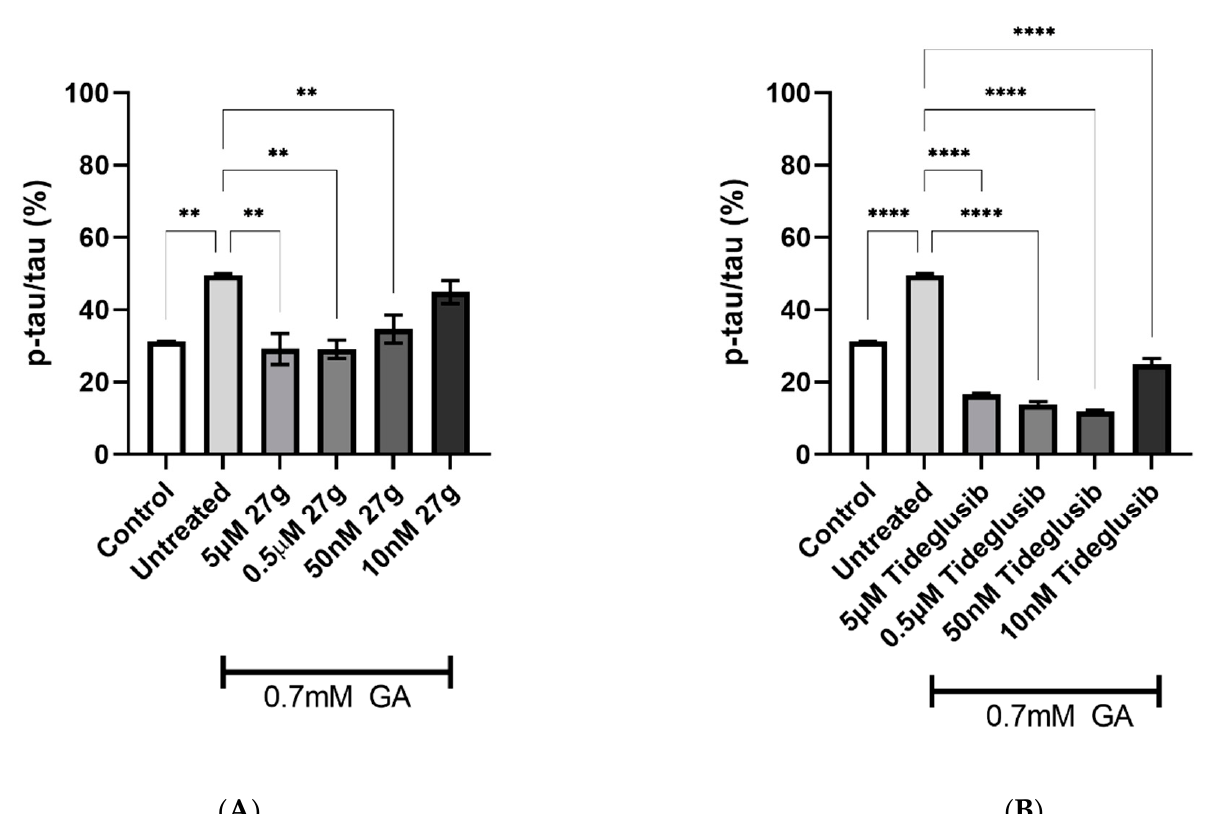
Figure 8. Reduction of Tau S396 phosphorylation after 27g treatment in 0.7 mM GA-exposed neurons. ( A ) Quantification of phosphorylation ratio pTau/tTau on S396 of 0.7 mM GA-treated SH-SY5Y- differentiated neurons after 27g treatment. ( B ) Quantification of phosphorylation ratio pTau/tTau on S396 of 0.7 mM GA-treated SH-SY5Y-differentiated neurons after Tideglusib treatment. Kruskal– Wallis test followed by Dunn’s post-hoc was used to compare the differences between different groups. Data are expressed as mean ± SEM, n = 3 with at least 5 repetitions per experiment; ** p < 0.01, **** p <